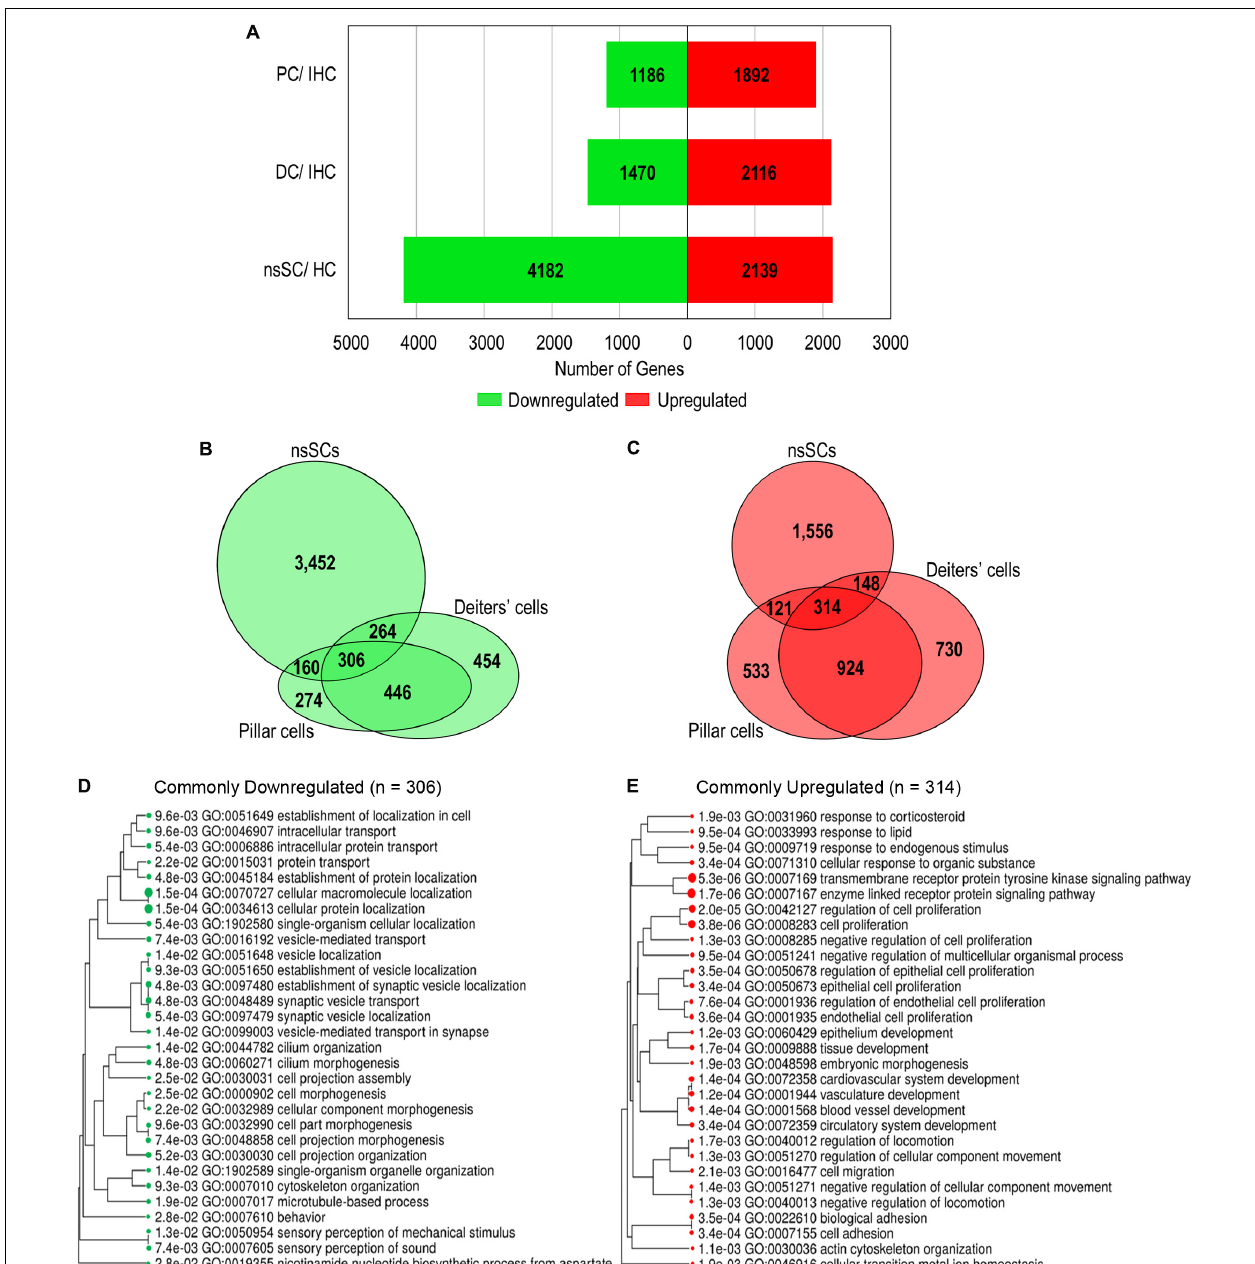
FIGURE 2 | Differential gene expression among vertebrate inner ear supporting cells. Differentially expressed genes were classified as those expressed ≥ 0.10 RPKM in each cell type (FDR-adjusted p -value ≤ 0.10), with a log2 fold change greater than 1.0 or less than –1.0. (A) The total number of upregulated (red) and downregulated (green) genes in zebrafish nsSCs compared to zebrafish HCs, as well as mouse DCs and PCs compared to IHCs of the organ of Corti. (B) Venn diagram showing the number of shared and unique downregulated genes in zebrafish nsSCs compared to HCs, and mouse PCs or DCs compared to IHCs. The size of the circle is relative to the number of genes. (C) The shared and unique upregulated genes among the supporting cell populations. (D) GO analysis (ShinyGO) of enriched biological processes of commonly downregulated gene orthologs in zebrafish nsSCs and mouse PCs and DCs ( n = 306). The hierarchal clustering tree shows related GO terms grouped together based on the number of common genes (FDR p -value ≤ 0.05). (E) GO enriched biological processes of the commonly upregulated genes ( n = 314).